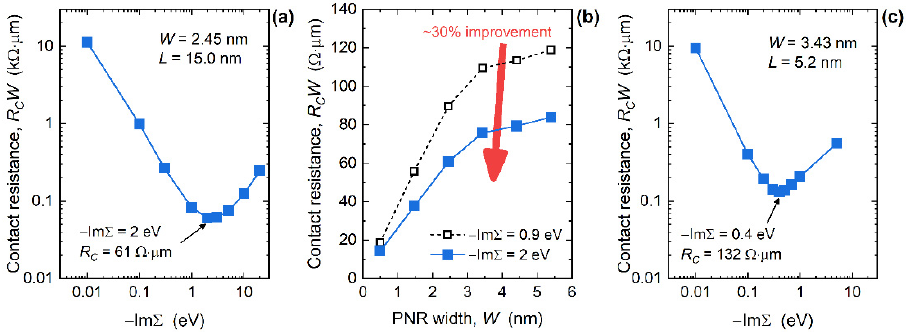
Figure 6. ( a ) Dependence of width-normalized contact resistance on interaction strength in 2.45 nm- wide and 15 nm-long PNRs with MECs. ( b ) Impact of PNR width downscaling on R C W for the two − Im Σ R values, initial and the optimum one. ( c ) R C W versus interaction strength in 3.43 nm-wide and 5.2 nm-long PNRs with MECs.